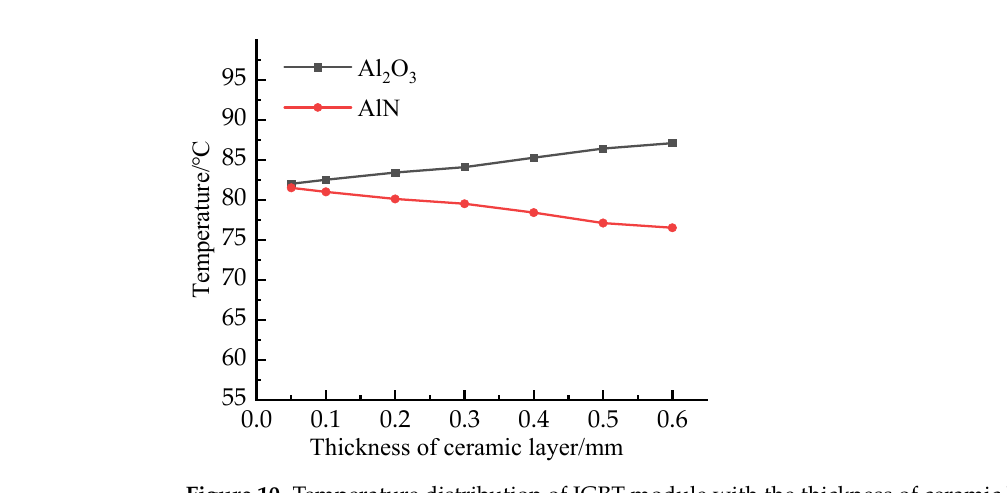
Figure 10. Temperature distribution of IGBT module with the thickness of ceramic layer.